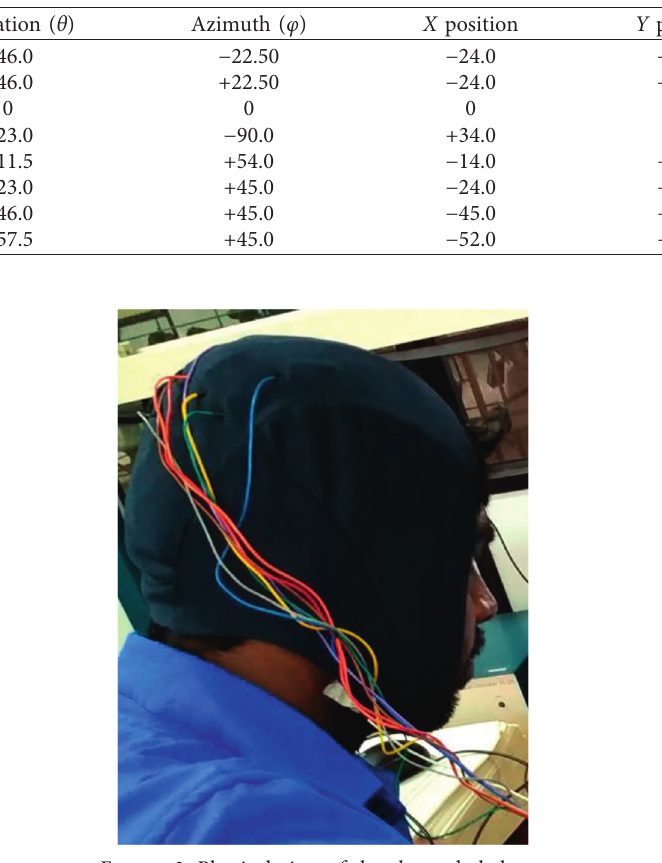
Table 3: Electrode positioning of the subject’s head.